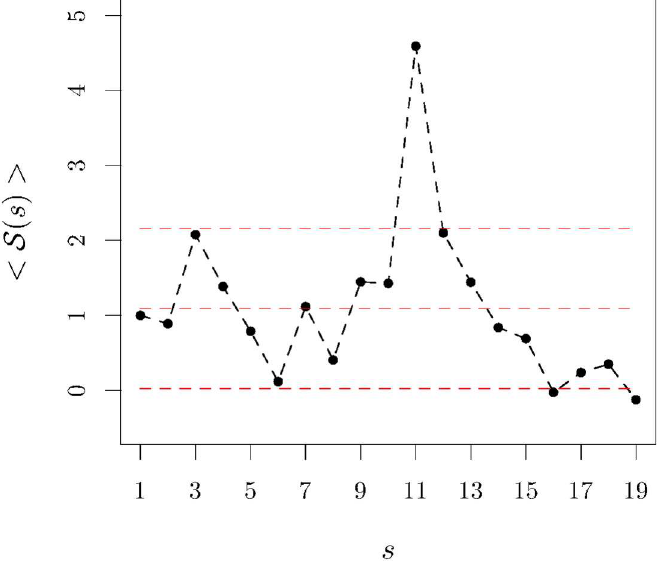
Fig 5. Symmetryof the traded volume v semester s . The black dots—with the black line as a guide to the eye—represent the values of the mean symmetry normalised by the value of h S ð 1 Þi ; the horizontallines signal the average value (computed over all companiesand semesters) and the upper and lower error